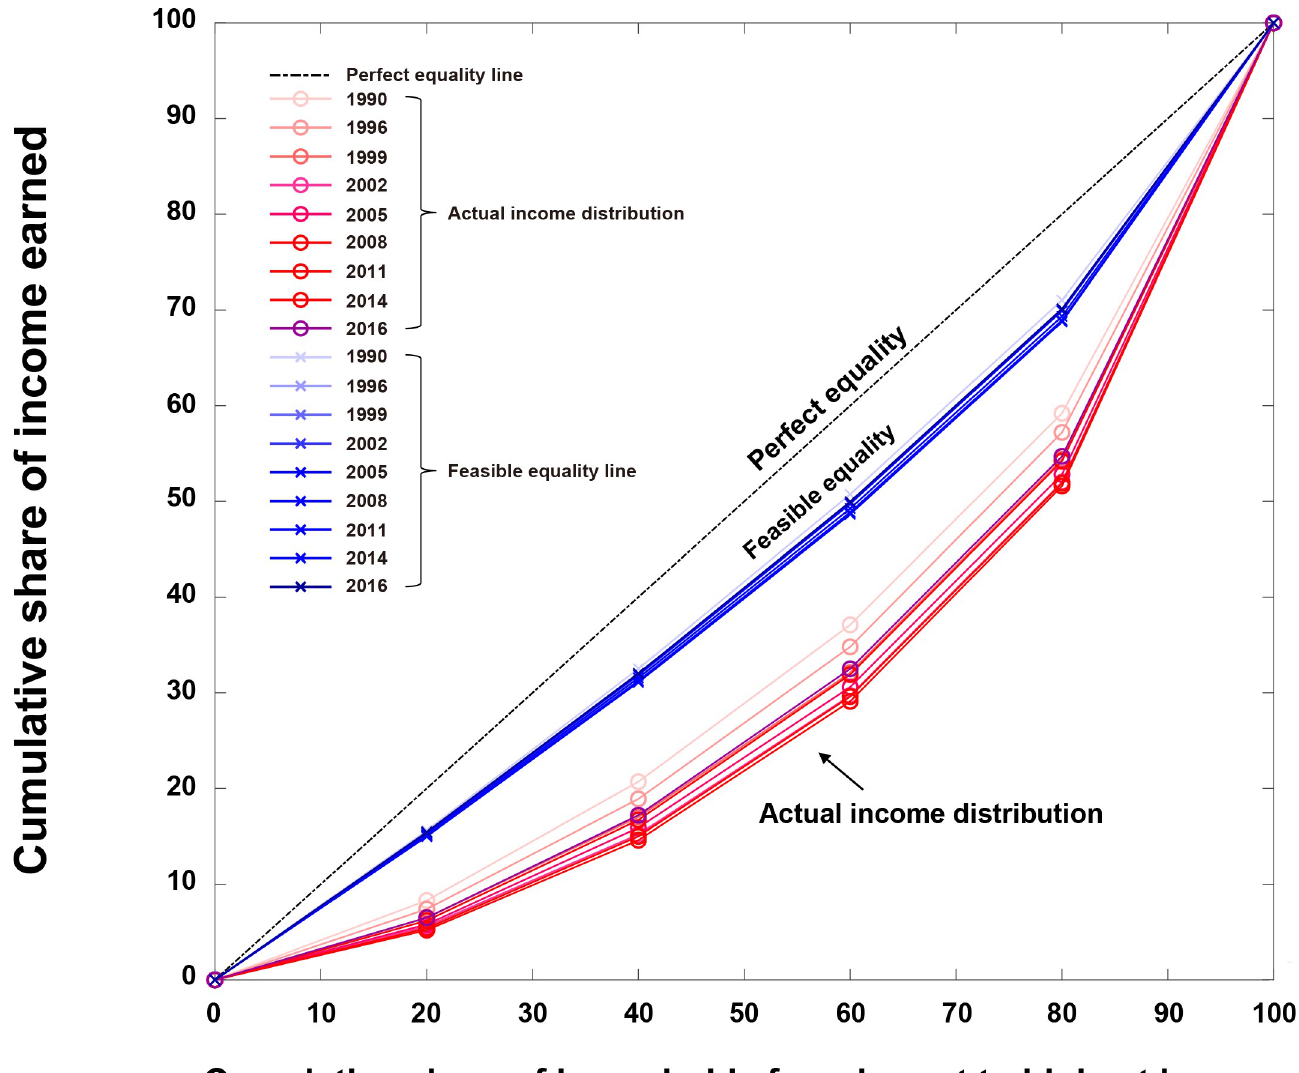
Fig 7. Lorenz curves for the actual and the optimal income distributions in China from 1990 to 2016. The corresponding Gini coefficients can be found in S3 Table. Note that the feasible equality lines (blue) are similar, while the actual income distributions are widely dispersed over time.